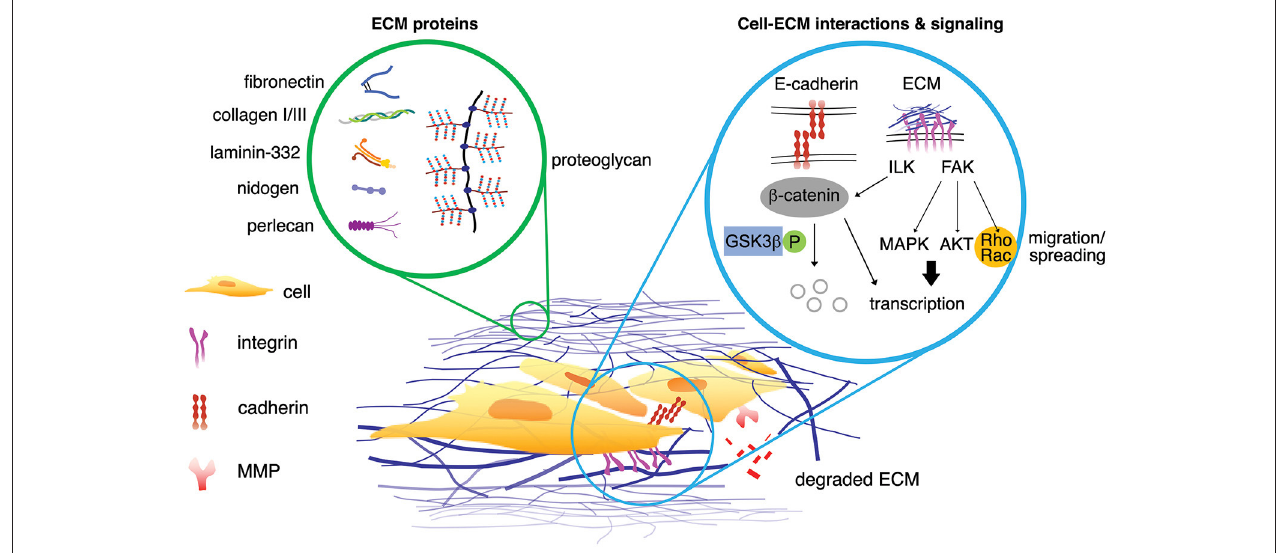
FIGURE 2 | Interstitial matrix proteins and the basement membrane proteins are associated in the breast cancer microenvironments (left circle). The signaling from the ECM proteins propagates via multiple signaling pathways either simultaneously or independently (right circle). Possible scenarios of cell-ECM interactions can initiate signaling of breast cancer cells. Upon phosphorylation, β -catenin dissociates from E-cadherin within adherens junction and is degraded by proteasome. ECM proteins can phosphorylate ILK, which in turn inhibits phosphorylation of GSK3 β and activate β -catenin (non-phosphorylated). ECM protein initiates phosphorylation of FAK, leading to enhanced translation of pro-survival and pro-proliferation genes associated with MAPK and AKT pathways. FAK also promotes Rho/Rac activity for actin cytoskeleton assembly, mediating cell migration and spreading. MMPs degrade ECM proteins, generating